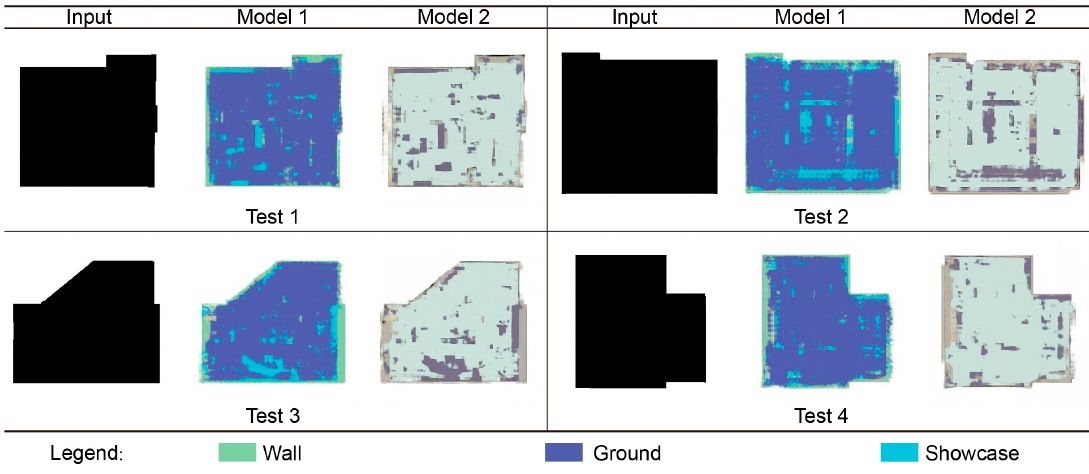
Figure 7. Utilizing the new FPP to test Model 1 and Model 2.